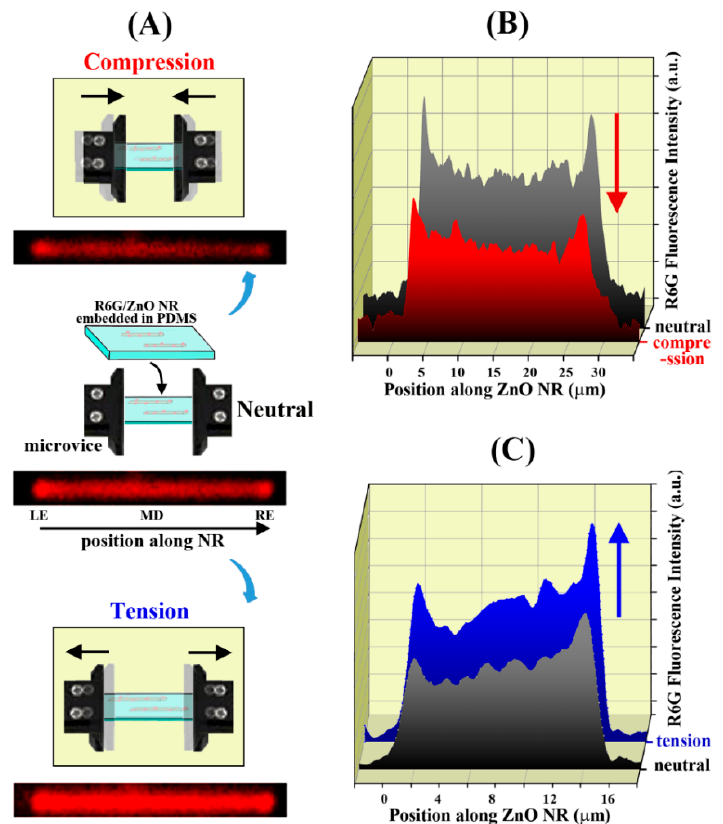
Figure 2. ( A ) The schematic illustrates the experimental set-up used to apply uniaxial compressive (above) or tensile (below) strain onto R6G/ZnO NRs embedded in a PDMS matrix. The red-colored fluorescence panel under each microvice setting qualitatively presents the waveguided emission profile of a R6G-coupled ZnO NR when the NR was subject to a compressive (above), neutral (center), and tensile (below) condition. ( B ) The plot quantitatively shows the change in the waveguided intensity values of R6G fluorescence measured along the NR long axis when the same ZnO NR was under a neutral versus compressive state. The red graph in the forefront is the fluorescence intensity under compression and the grey graph behind shows the fluorescence intensity without strain. The red arrow highlights the decreasing trend of the waveguided fluorescence intensity under compression. ( C ) A similar plot of R6G fluorescence intensity versus the position along the ZnO NR is displayed for tension. The blue graph in the back is for the fluorescence intensity when the NR underwent tensile strain and the grey graph in the forefront is from the neutral state. Unlike the compressive case in ( B ), an increase in the waveguided fluorescence intensity was detected when the NR was under tension, and this is highlighted by the blue arrow.